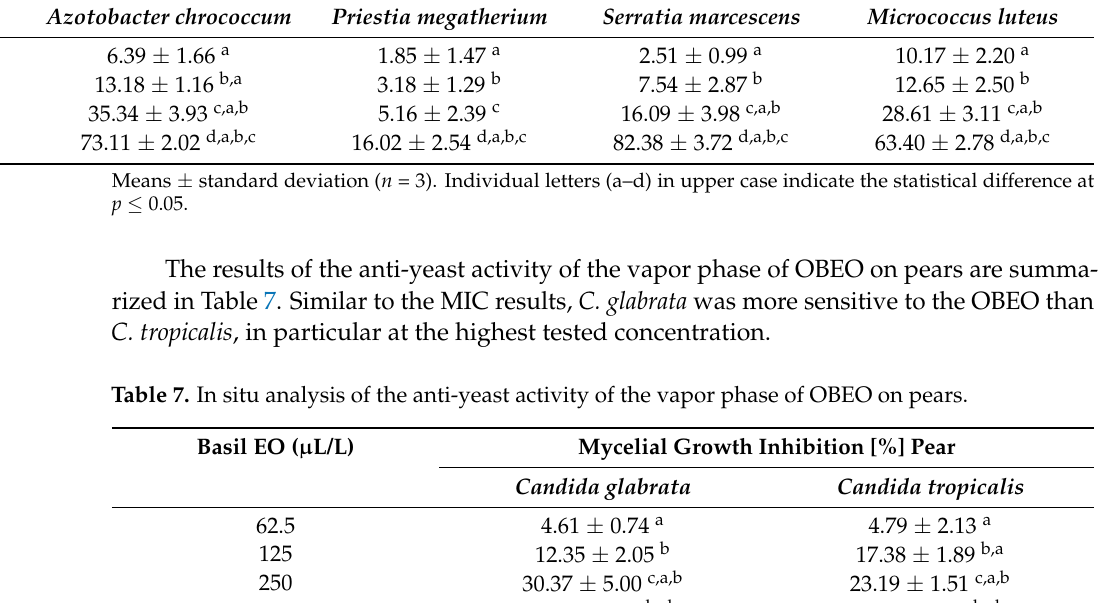
Table 6. In situ analysis of the antibacterial activity of the vapor phase of OBEO on pears. Basil EO ( µ L/L)